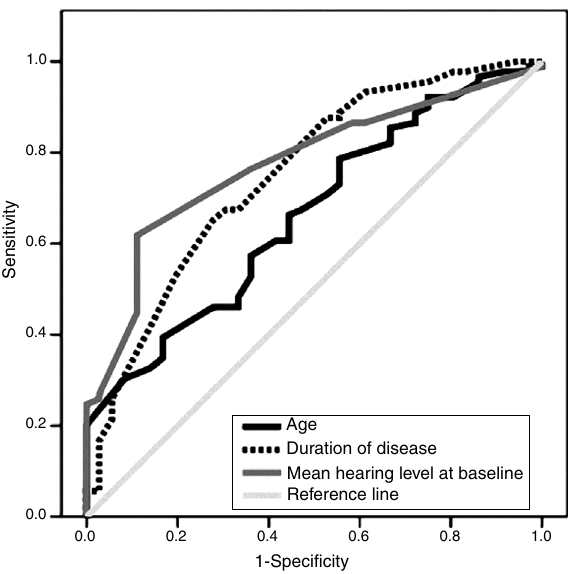
Receiver operator characteristics’ curves of patients’ age, baseline hearing level, and disease duration in predicting persistent hearing loss six months after treatment. Area under the curve: 0.66 for age, 0.76 for baseline hear- ing level, and 0.75 for disease duration ( p = 0.01, <0.001, and <0.001,